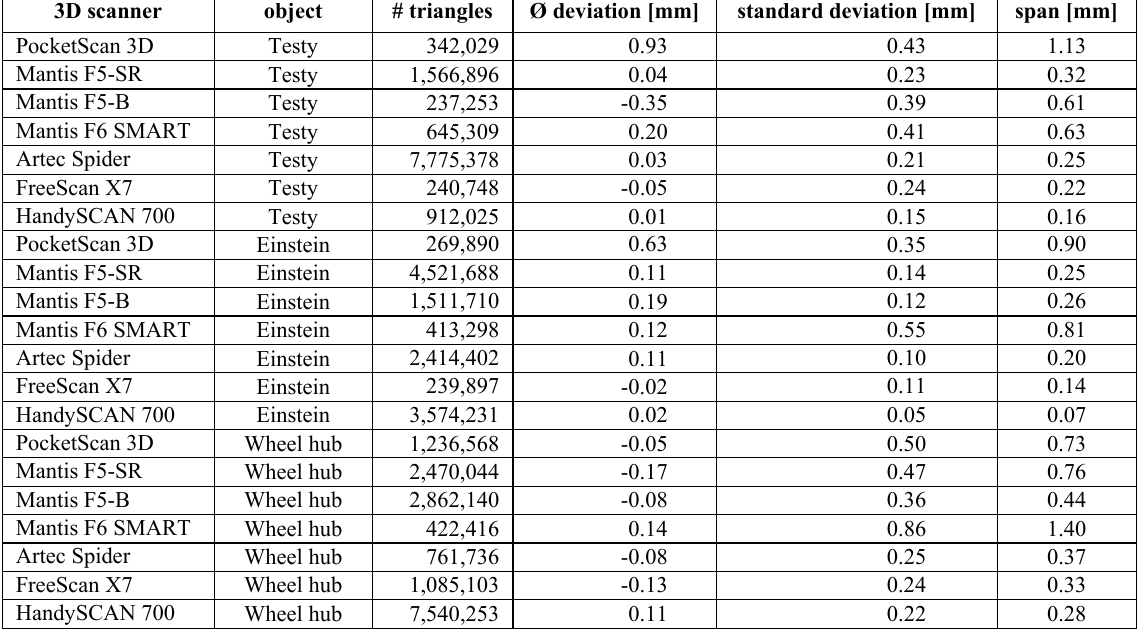
Table 3. Average deviations (Ø dev.) for the three test bodies – 3D comparison with Geomagic Studio 2012 between